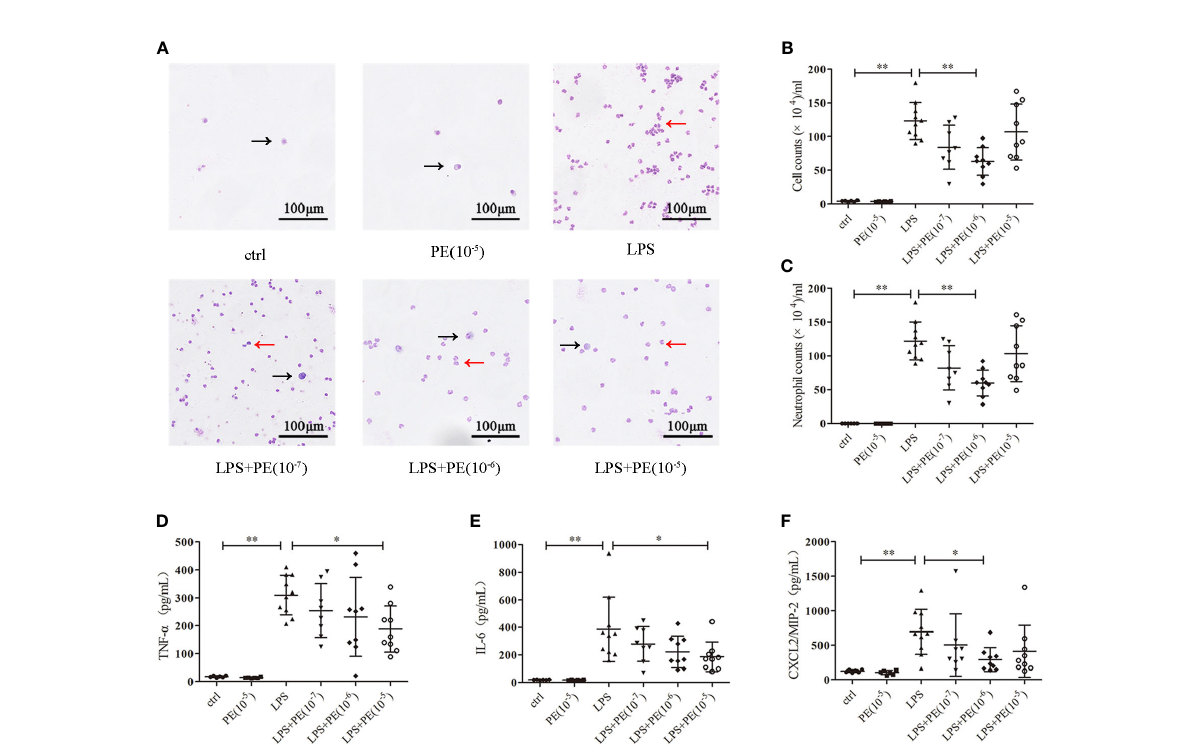
FIGURE 2 Phenylephrine (PE) ameliorated lung in fl ammation in ARDS mice. Mice were given an intratracheal instillation of 2 mg/kg lipopolysaccharide (LPS) to induce ARDS, and PE was injected into trachea 20 min before LPS stimulation. Lung tissues and bronchoalveolar lavage fl uid (BALF) were collected 24 h after stimulation with LPS. (A) In fl ammatory cells in BALF stained by Wright-Giemsa stain. Scale bar = 100 m M. (B) Counts of total in fl ammatory cells in BALF. (C) Counts of neutrophils in BALF. Levels of TNF- a (D) , IL-6 (E) , and CXCL2/MIP-2 (F) in BALF. Data are represented as the mean ± SD, n = 6 – 10 per group. * p < 0.05, ** p <